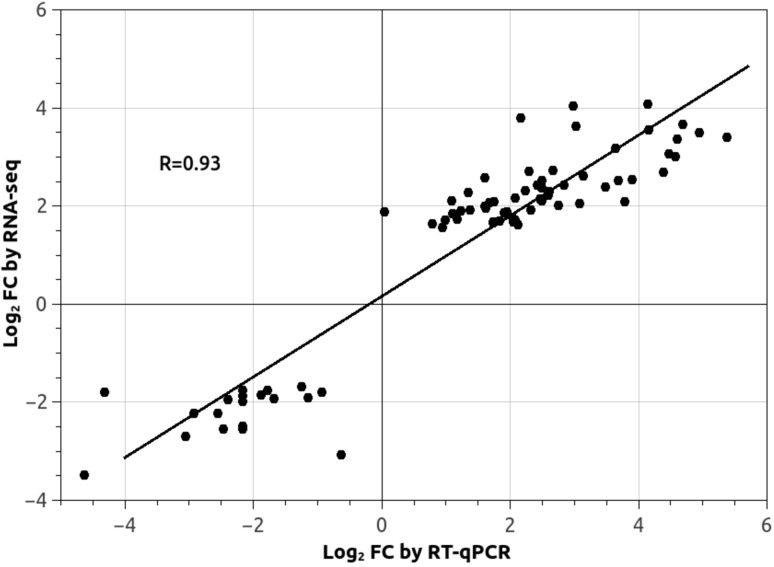
Correlation between the relative quantification of RNA-seq and RT-qCR results.Correlation between differential expression inferred by bioinformatics predictions (log2 FC by RNA-seq) and RT-qPCR analysis (log2 FC by RT-qPCR). The value represents the log2 of the relative fold change (FC) between control and 1 mM Zn treatment. Regression line and Pearson' s correlation coefficient are shown.